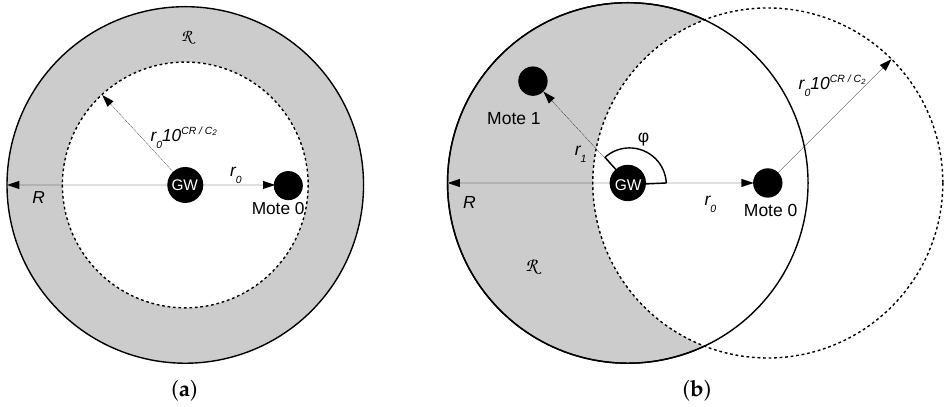
Figure 4. Mote locations for various cases: ( a ) mote 1 location when data frame of Mote 0 is successful in case of collision. ( b ) Mote 1 location when ACK is successful if it collides with